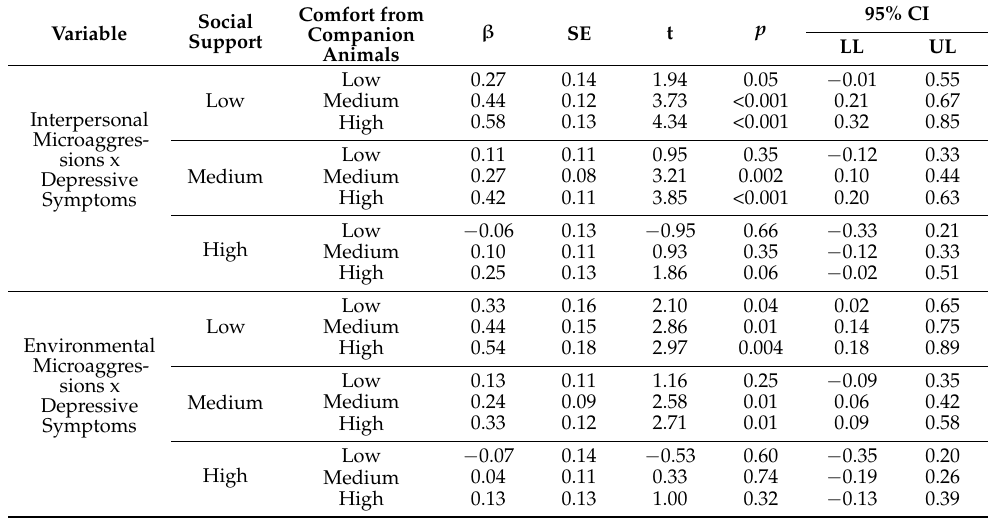
Table 3. Conditional effects of interpersonal and environmental microaggressions on depressive symptoms at different levels of social support and comfort from companion animals ( n =